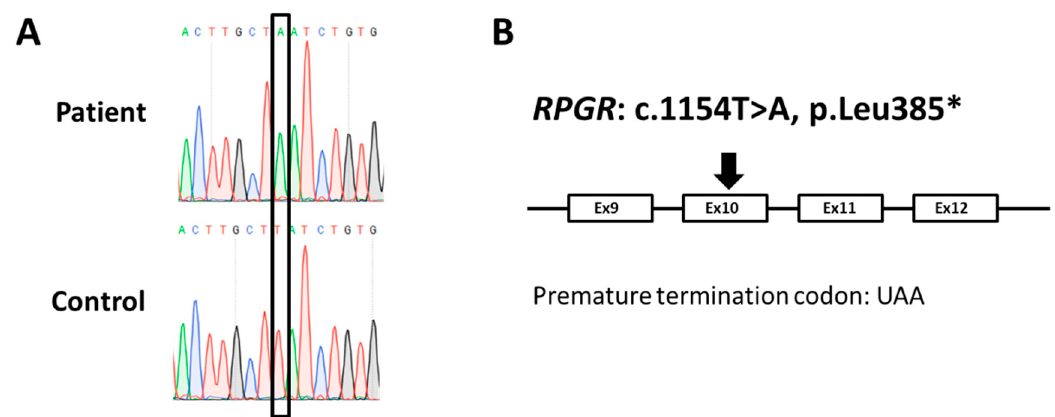
Figure 2. A novel nonsense mutation identified in the RPGR gene. ( A ) Electropherograms of the index patient and a control. Sanger sequencing of the index patient´s genomic DNA showed a hemizygous adenine sequence alteration at position c.1154 in exon 10 of the RPGR gene. In contrast, the unaffected control (male) contained a thymine base at the same position, representing the reference sequence of RPGR . The black frame marks the sequence alteration at nucleotide c.1154 in RPGR ( RPGR reference sequence NM_000328.3). ( B ) Schematic drawing of the RPGR gene illustrating the position of the mutation. We identified a single base substitute (c.1154T > A) in exon 10 of RPGR leading to the premature termination codon UAA (p.Leu385*).